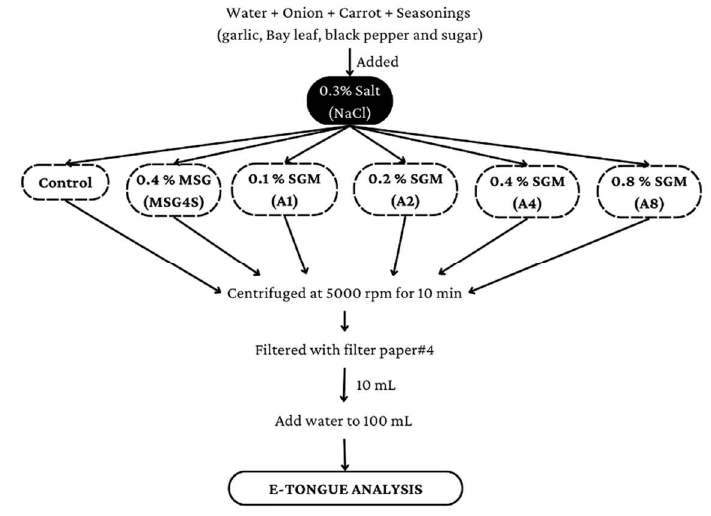
Figure 2. Preparation process of flavored clear soup for E-tongue analysis.